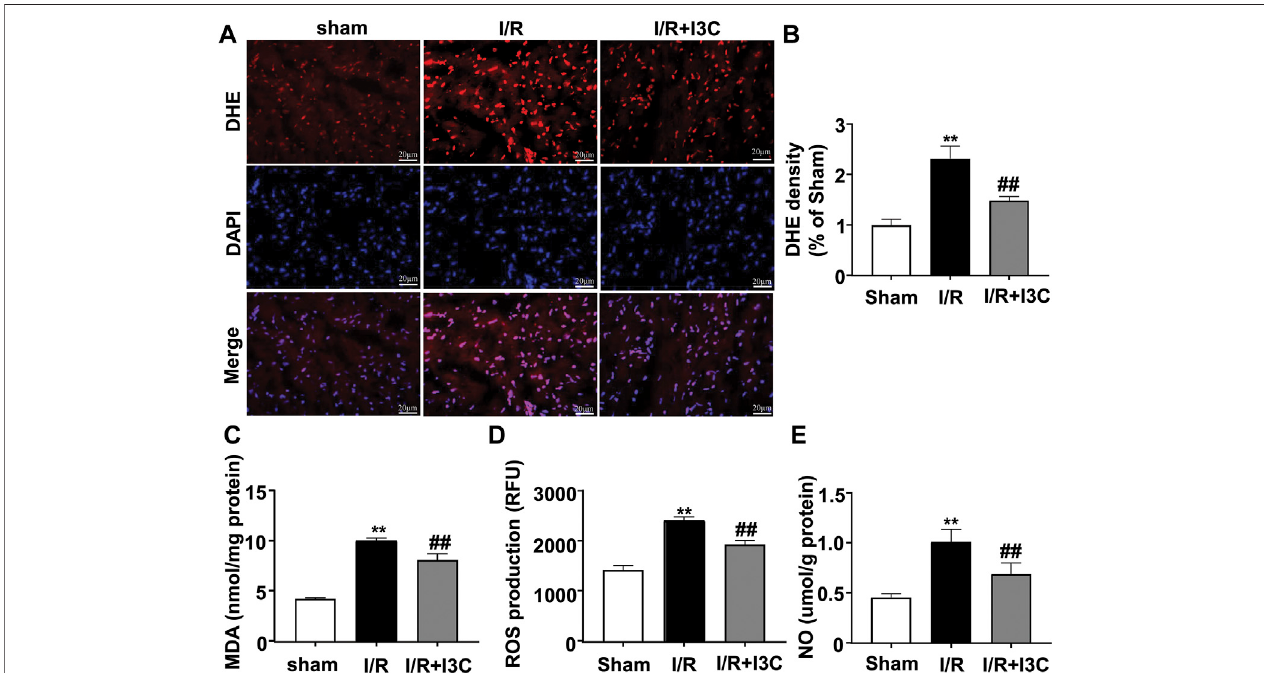
FIGURE 3 | Effect of I3C on pro-oxidant stress parameters in myocardial tissue of I/R mice. (A,B) Representative images (A) and quantitative analysis (B) showed that I3C pretreatment (100 mg/kg) prevented the I/R-induced increase in the number of DHE-positive cells in ischemic cardiac tissue ( n = 5, ** p < 0.01 vs. sham treatment, ## p < 0.01 vs. I/R). (C – E) Quantitative analysis showed that I3C pretreatment prevented the I/R-induced increase in MDA (C) , ROS (D) , and NO (E) levels in ischemic heart tissue ( n = 5, ** p < 0.01 vs. sham treatment, ## p < 0.01 vs. I/R). Scale bars: 20 μ m. Data are expressed as mean ± SEM.